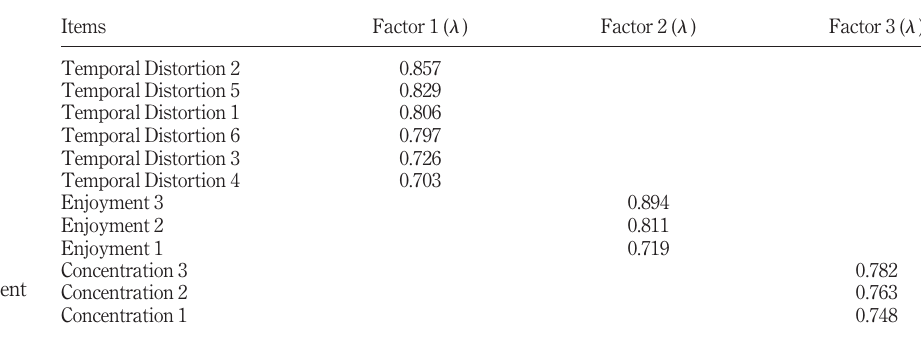
Table III. Rotated component matrix